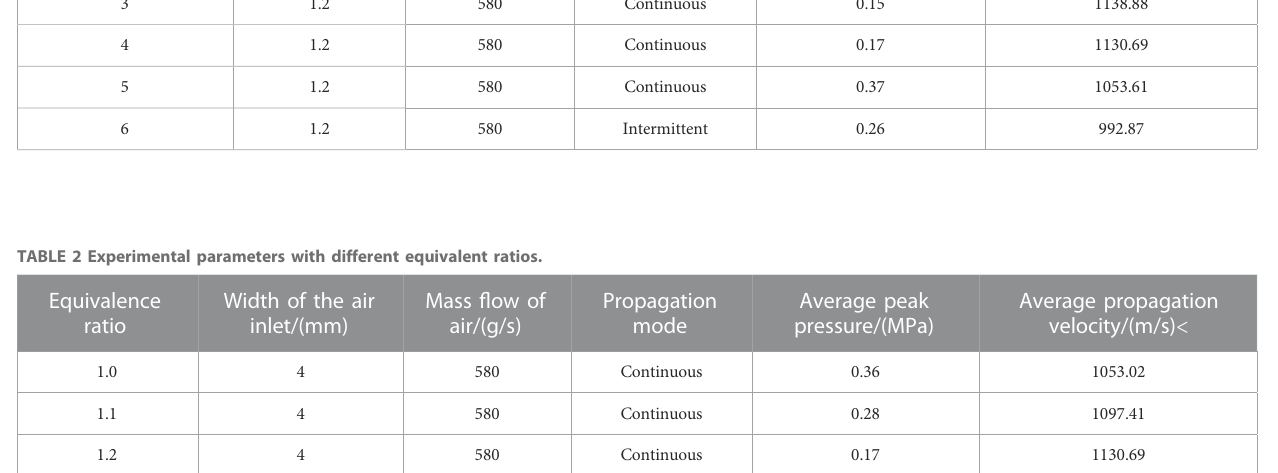
TABLE 1 Experimental parameters with different widths of the air inlet. Width of the air inlet/(mm)